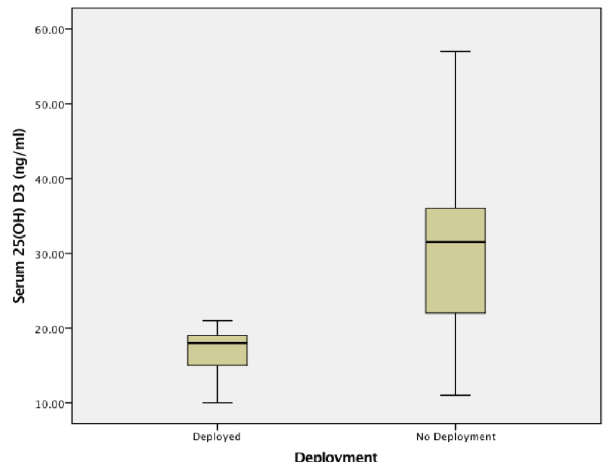
Figure 2. Seasonally adjusted serum 25(OH)D 3 (ng / mL) levels drawn from the U.S. Navy Sailors. Data in the box plots compare serum 25(OH)D 3 levels drawn from non-cadre Navy Sailors ( n = 6) who processed through the Deployment Processing Command East (DPC-E), (typically demobilizing) from U.S. Marine units with those U.S. Navy Sailors ( n = 6) who were not deployed but who were assigned to the DPC-E as cadre. Biomolecules 2020 , 10 , x FOR PEER REVIEW